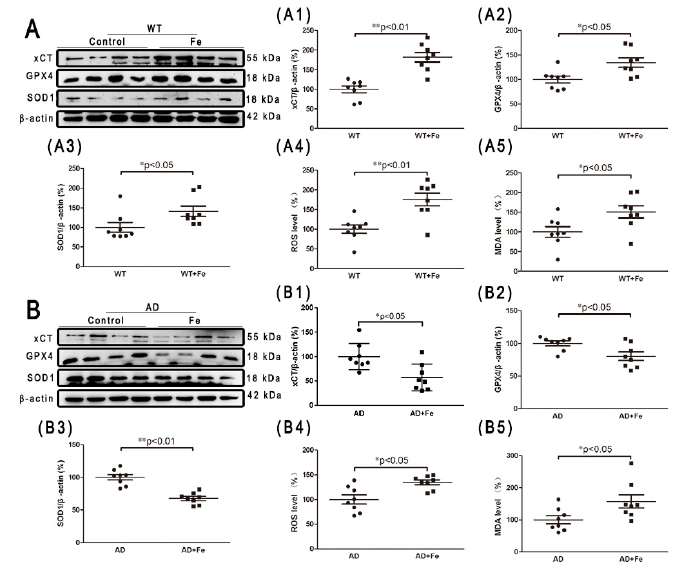
Figure 4. HDI-induced redox status in the mouse brain. ( A , B ) Western blot analysis of glutamate-cystine transporter (xCT), glutathione peroxidase 4 (GPX4), and superoxide dismutase (SOD1). ( A1 – A3 , B1 – B3 ) Quantitative analyses of Western blot for xCT, GPX4, and SOD1. β -actin was used as an internal control. ( A4 , A5 , B4 , B5 ) Quantitative analyses of reactive oxygen species (ROS) and malondialdehyde (MDA). All results are presented as the mean ± SEM ( n = 8). * p < 0.05, ** p < 0.01.